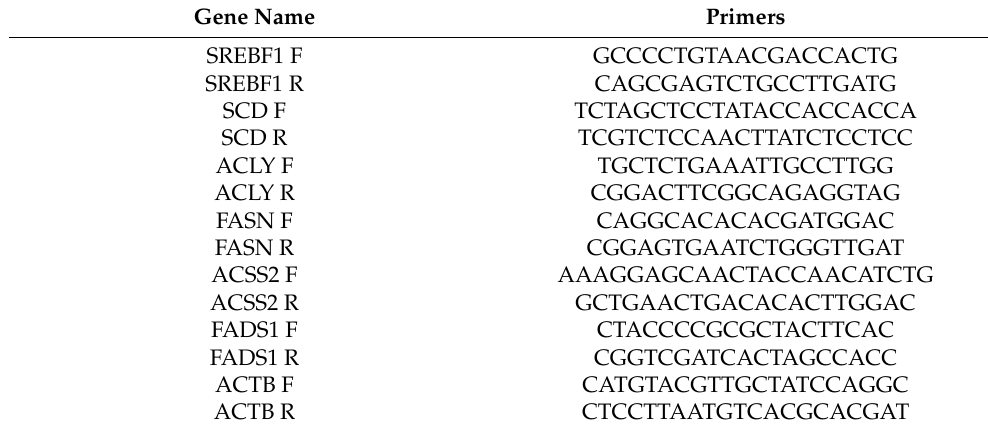
Table 2. RT-qPCR